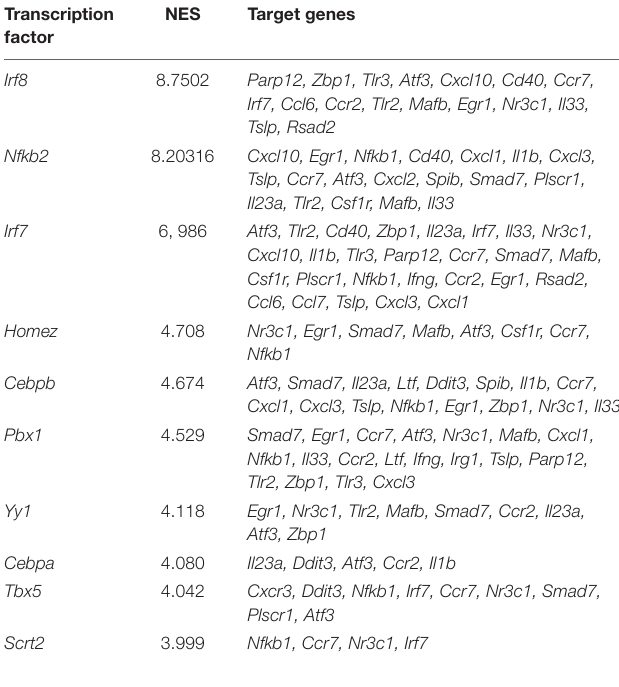
TABLE 1 | Top 10 transcription factors obtained by